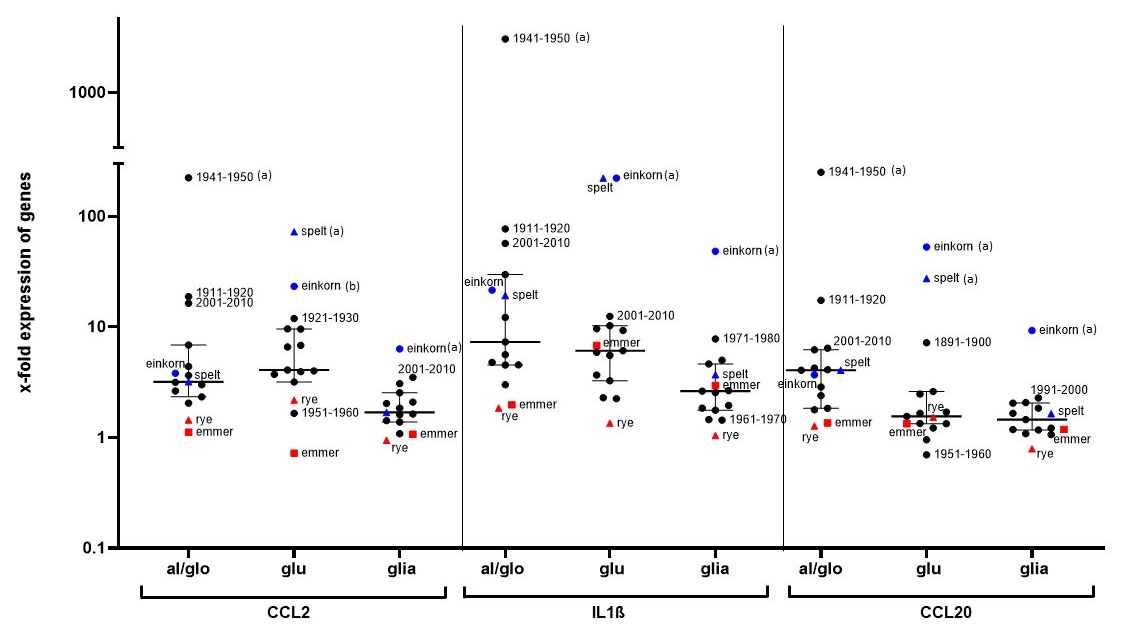
Figure 5. X-fold upregulation of CCL2, IL1ß, and CCL20 in THP1 cells after stimulation with cereal proteins. Gene expression is shown after 24h stimulation of THP1 cells with a peptic-tryptic digestion of albumin/globulin fractions (al/glo), glutenins (glu), or gliadins (glia) (0.5 mg/mL each). Fold-change gene expression was calculated with the 2 − ∆∆ Ct method, using GAPDH as a housekeeping gene, and was related to values for the culture medium without stimulants as a baseline. Data are shown as medians with interquartile range of two independent biological experiments with technical replicates, respectively. One-way ANOVA with multiple Tukey test was used to reveal significant changes in gene expression. (a) Significant differences to all other cereal fractions; (b) significant differences compared to wheat cultivar 1951–1960, rye, spelt, and emmer.